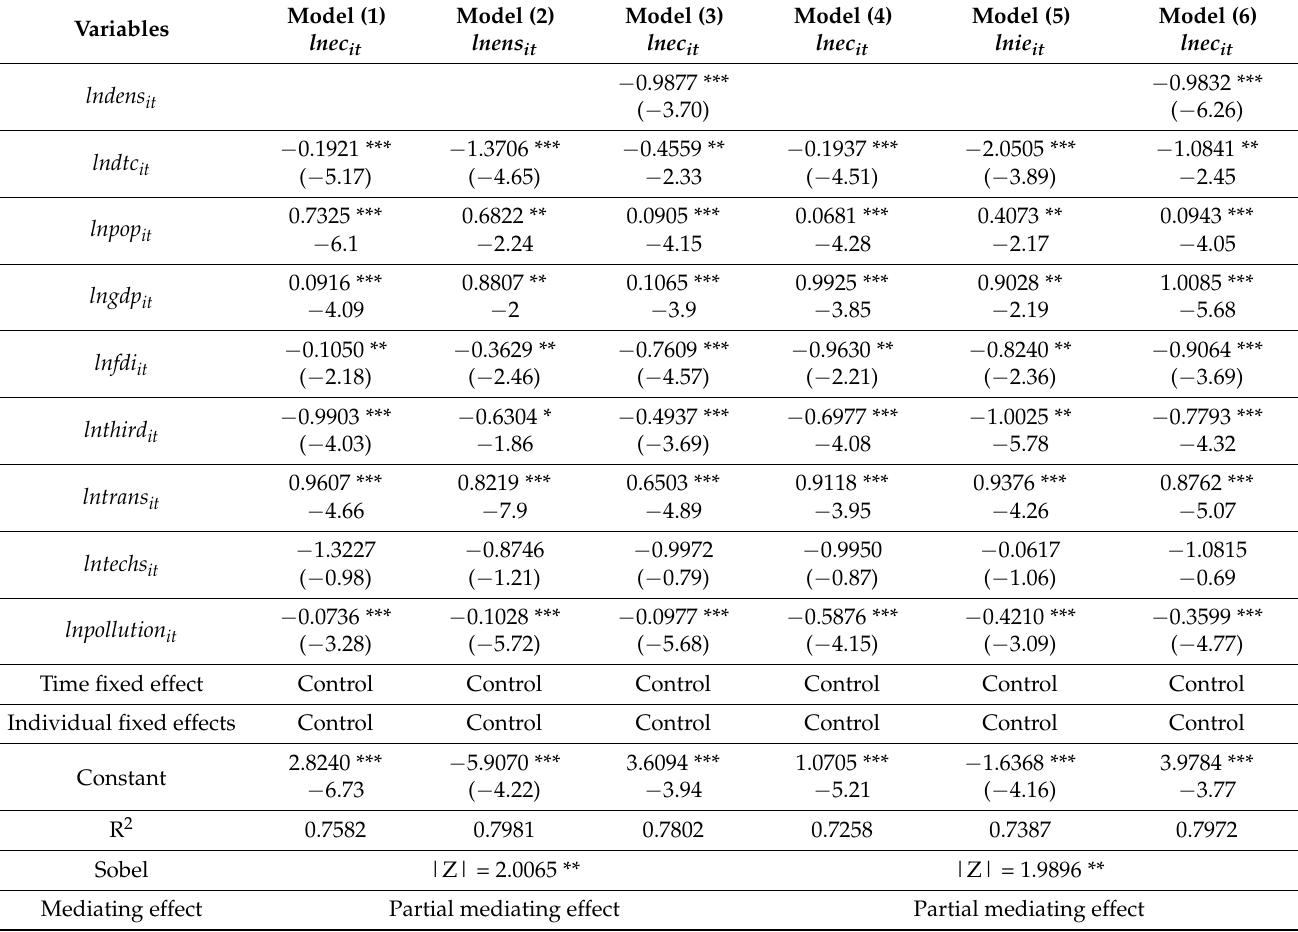
Table 6. Mediation effect regression results of energy structure and innovation